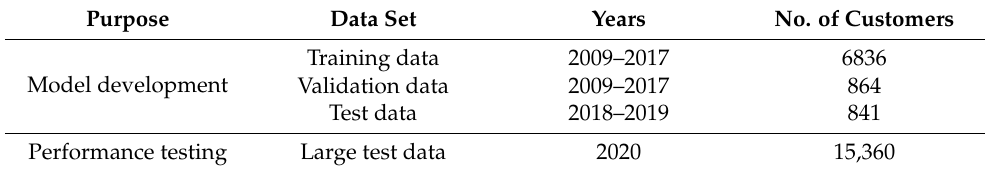
Table 1. Total number of observations in data sets used in this paper.